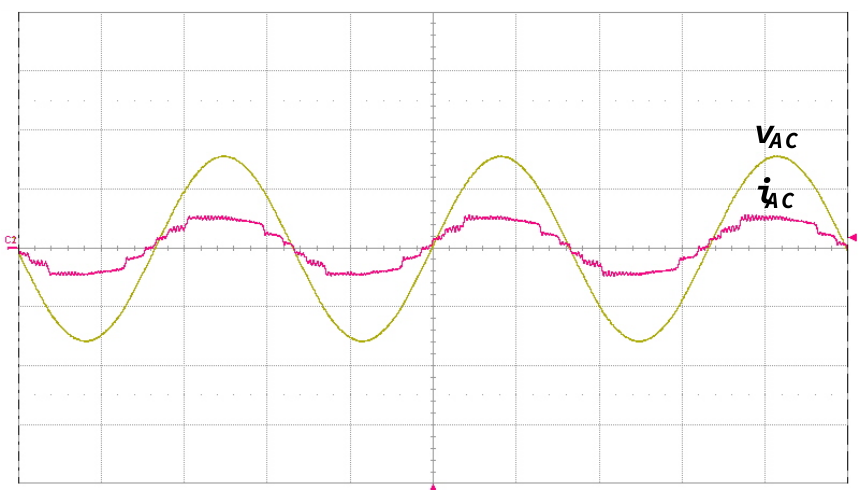
Figure 13. Measured input utility-line voltage v AC (200 V/div) and current i AC (2 A/div); time scale: 5 ms/div.